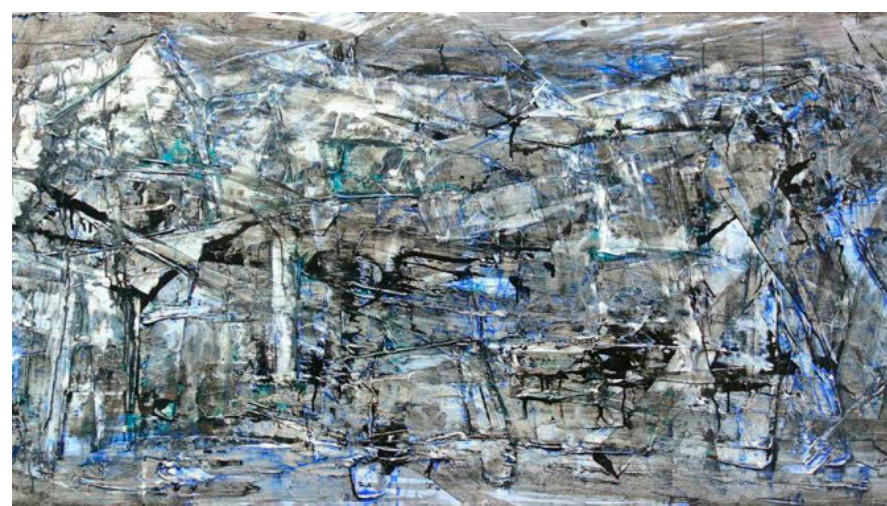
Figure A1. Nguyen Ro Hung’s copied painting with Pham An Hai’s signature 1. The image was sourced from Tuoi Tre Newspaper (Viet 2017).